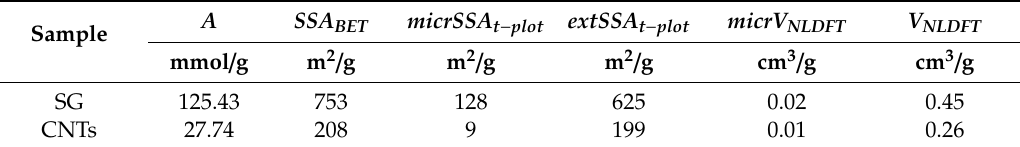
Table 5. Structural parameters of SG and